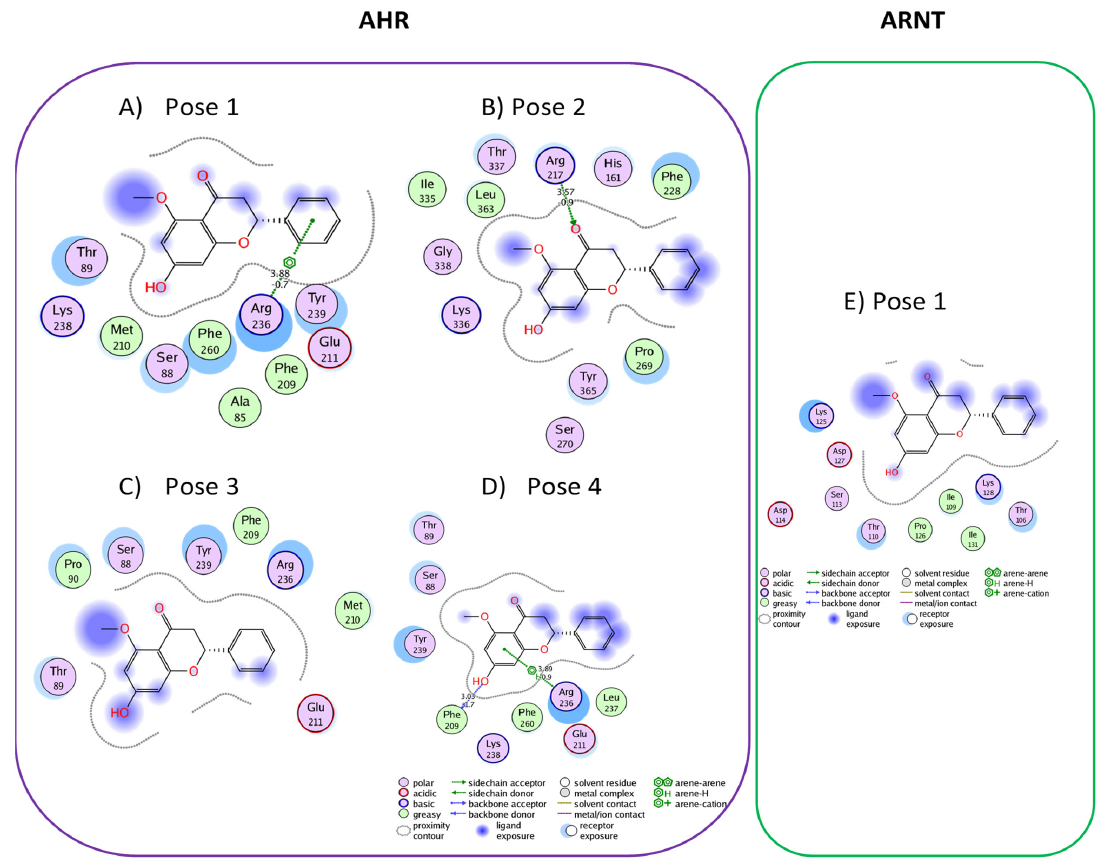
Figure 13. Interaction network between monomeric protein AHR, ARNT and the studied compound 16 .